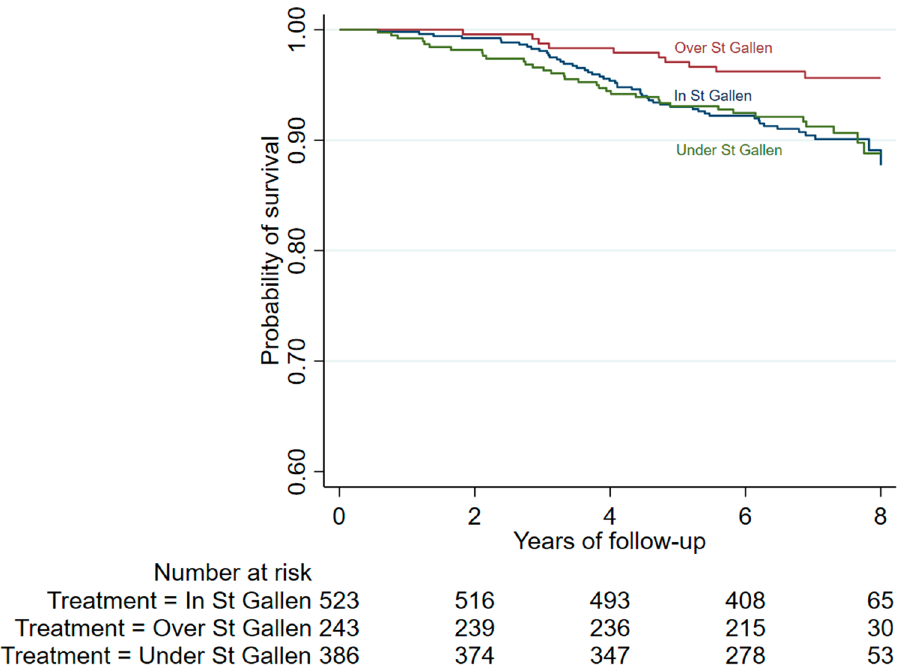
Figure 3. Crude Kaplan–Meier estimates of overall survival probability according to St Gallen fulfilment. Five- year survival probabilities were 97.1 for women treated over St Gallen, 93.1 for women treated under St Gallen and 93.0 for women treated in St